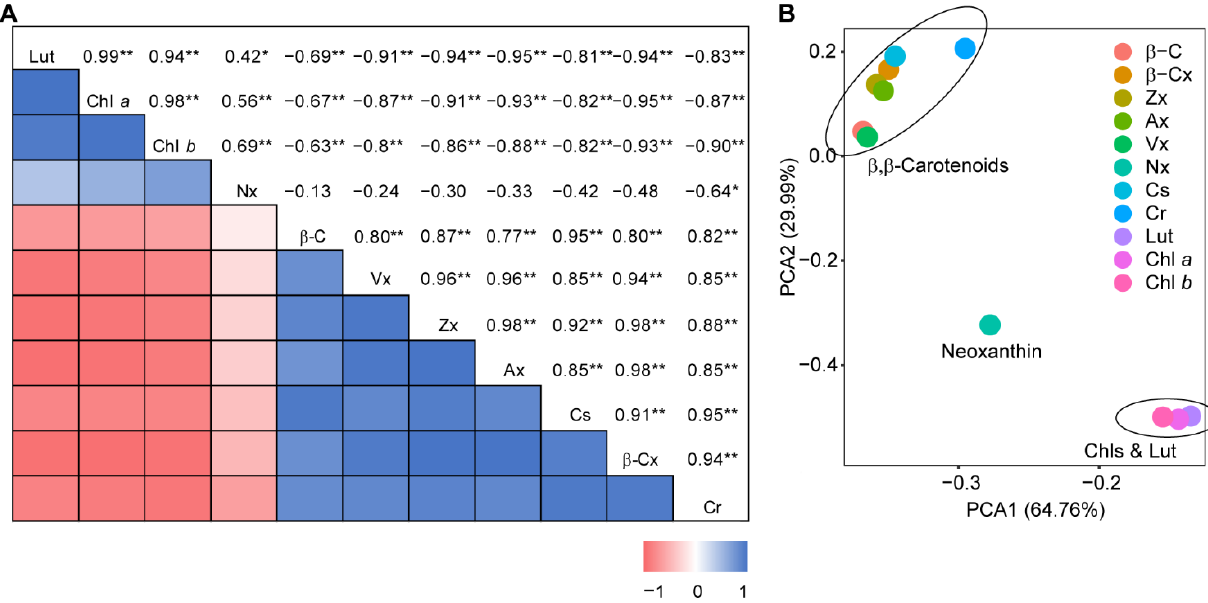
Figure 3. Correlation analysis of carotenoid constituents in chili pepper fruit. ( A ) The correlation matrix between carotenoid contents in pepper fruits. Asterisks indicate significant differences at p < 0.05 (*) and p < 0.01 (**) levels (measured by the cor.test function in R). ( B ) The principal components analysis (PCA) of pigment constituents during ripening. Abbreviations for pigments are β -C, β -carotene; β -Cx, β -cryptoxanthin; Zx, zeaxanthin; Ax, antheraxanthin; Vx, violaxanthin; Nx, neoxanthin; Cs, capsanthin; Cr, capsorubin; Lut, lutein; Chl a , chlorophyll a ; Chl b , chlorophyll b .